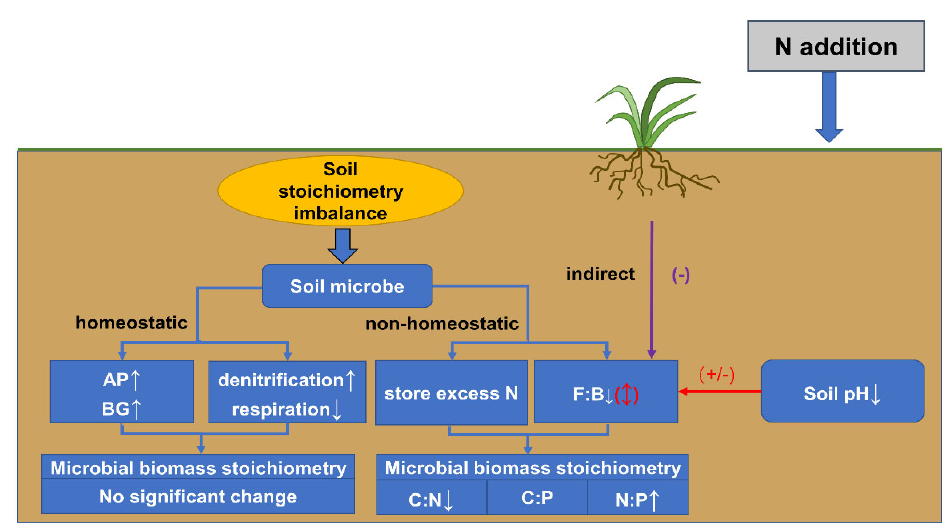
Figure 1. A conceptual framework for the responses of soil microbial biomass stoichiometry to N addition in alpine ecosystems. ↑ , increase; ↓ , decrease; ( ↕ ), increase or decrease in response to soil pH decline; ( − ), negative effect; (+/ − ), negative or passive effect; AP, acid phosphatase; BG, β‐ 1,4 ‐ glucosidase; F:B, fungi ‐ to ‐ bacteria ratio.